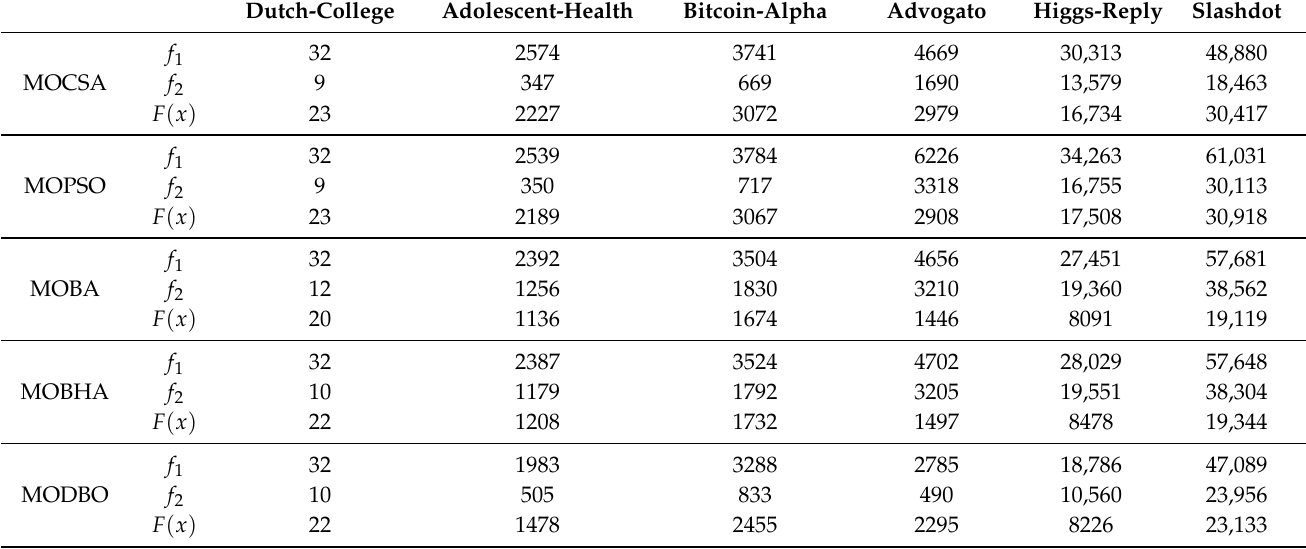
Table 2. Computational results of different algorithms on six real social